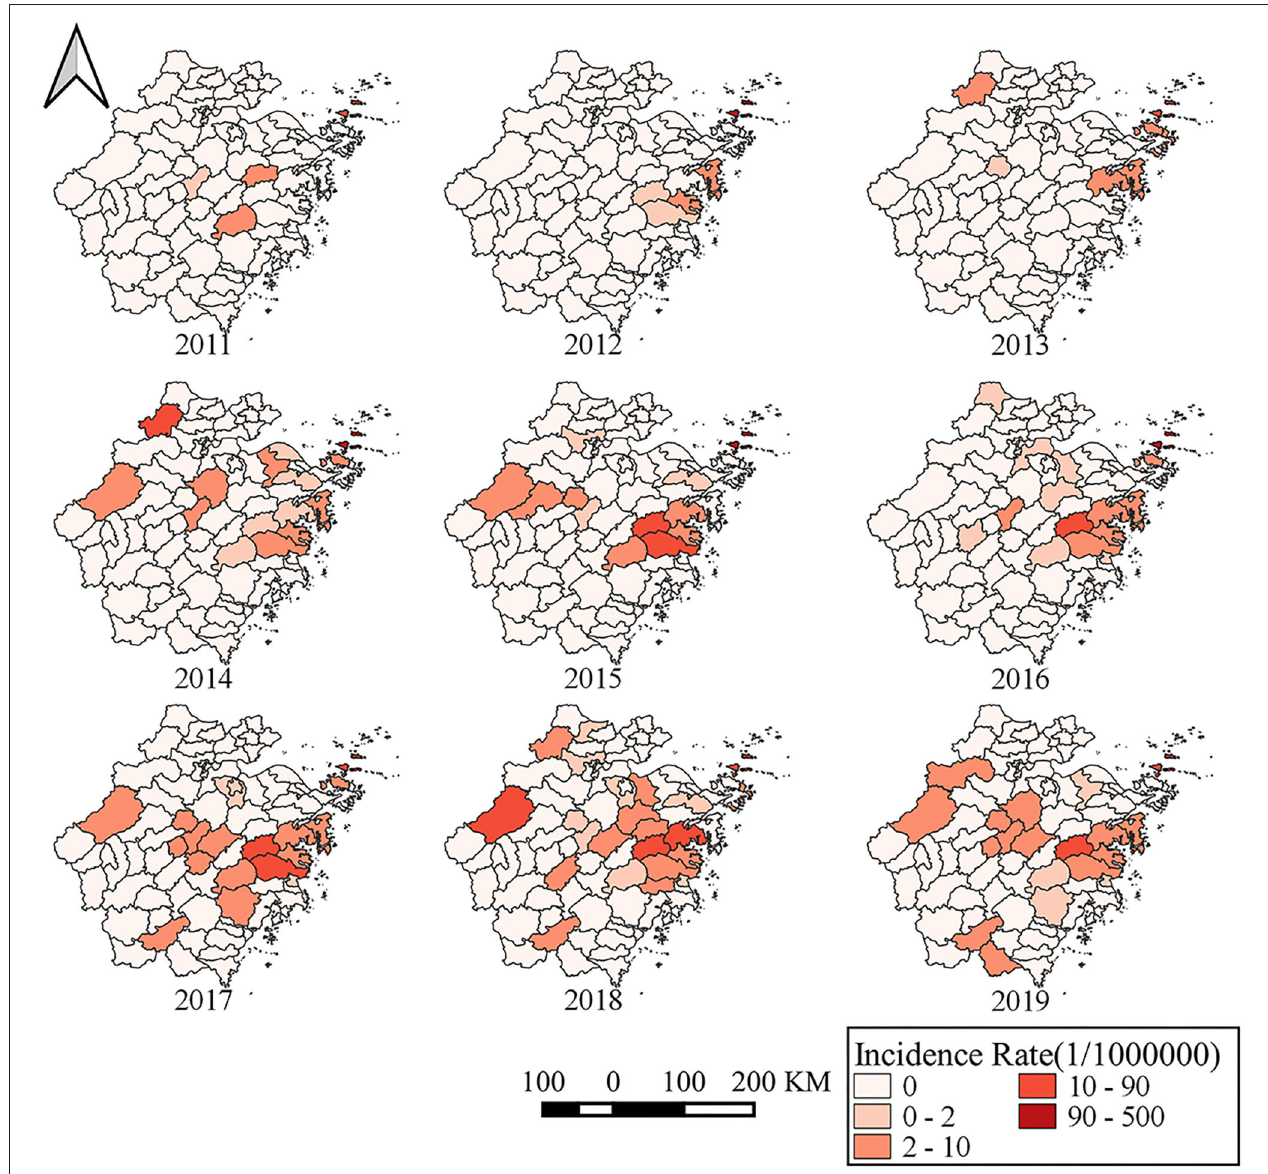
FIGURE 4 | The annual incidence rates of different counties in Zhejiang Province from 2011 to